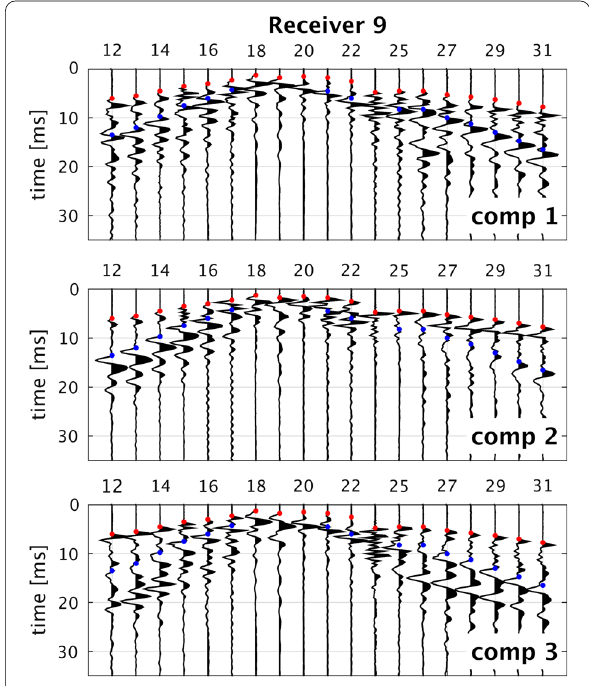
Fig. 3 Example of a receiver gather at receiver 9 with shot points starting in niche 8 with SP12 to SP31 (except SP23) in gallery 08 (Fig. 1A along gray dotted line). Red dots indicate traveltime picks for P-waves and blue dots for S-waves. Shown are the three components of the geophone. comp 1: vertical, comp 2: parallel and comp 3: perpendicular to the tunnel